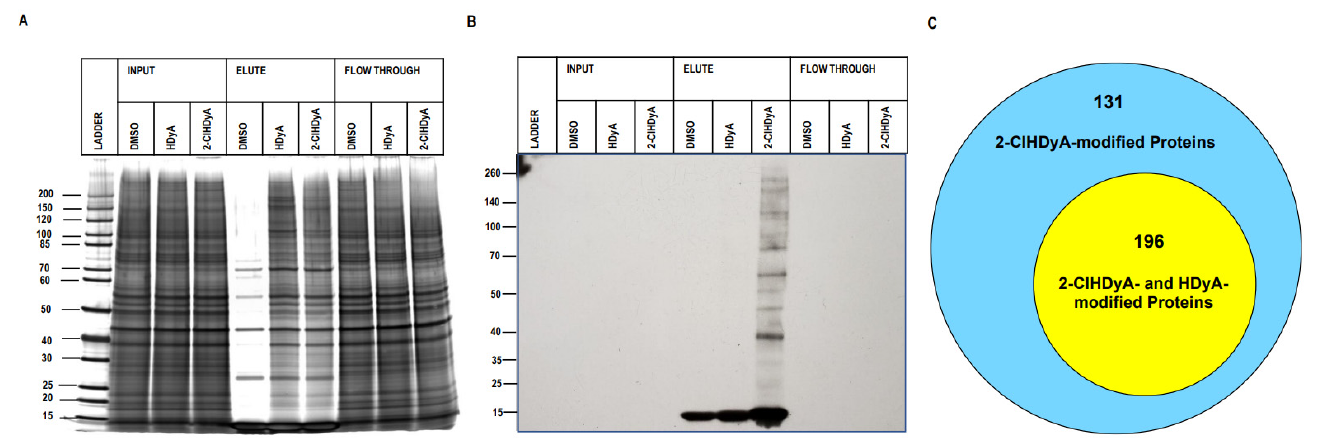
Figure 7. 2-ClHDyA modified HLMVEC cell proteins. Silver-stained gel ( A ) and Western blot ( B ) probed with streptavidin HRP of the samples from A were prepared, as described in “Materials and Methods”. Protein loads showing total proteins from lysates from each indicated condition (DMSO vehicle, HDyA (non-chlorinated aldehyde control), and 2-ClHDyA) input onto beads, elute from beads, and supernatant (Flow Through); ( C ) Venn diagram of number of 2-ClHDyA- and HDyA-modified proteins in HLMVECs.